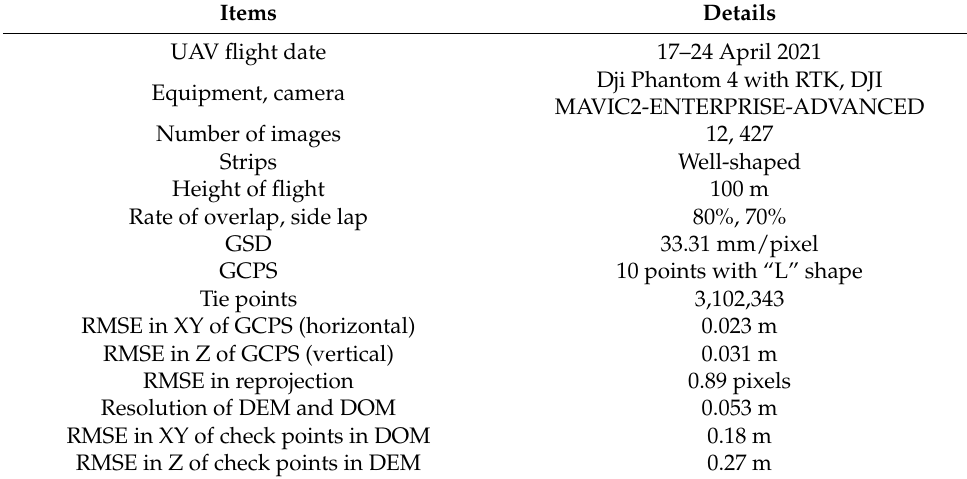
Table 1. Information related to UAV flight and image processing.